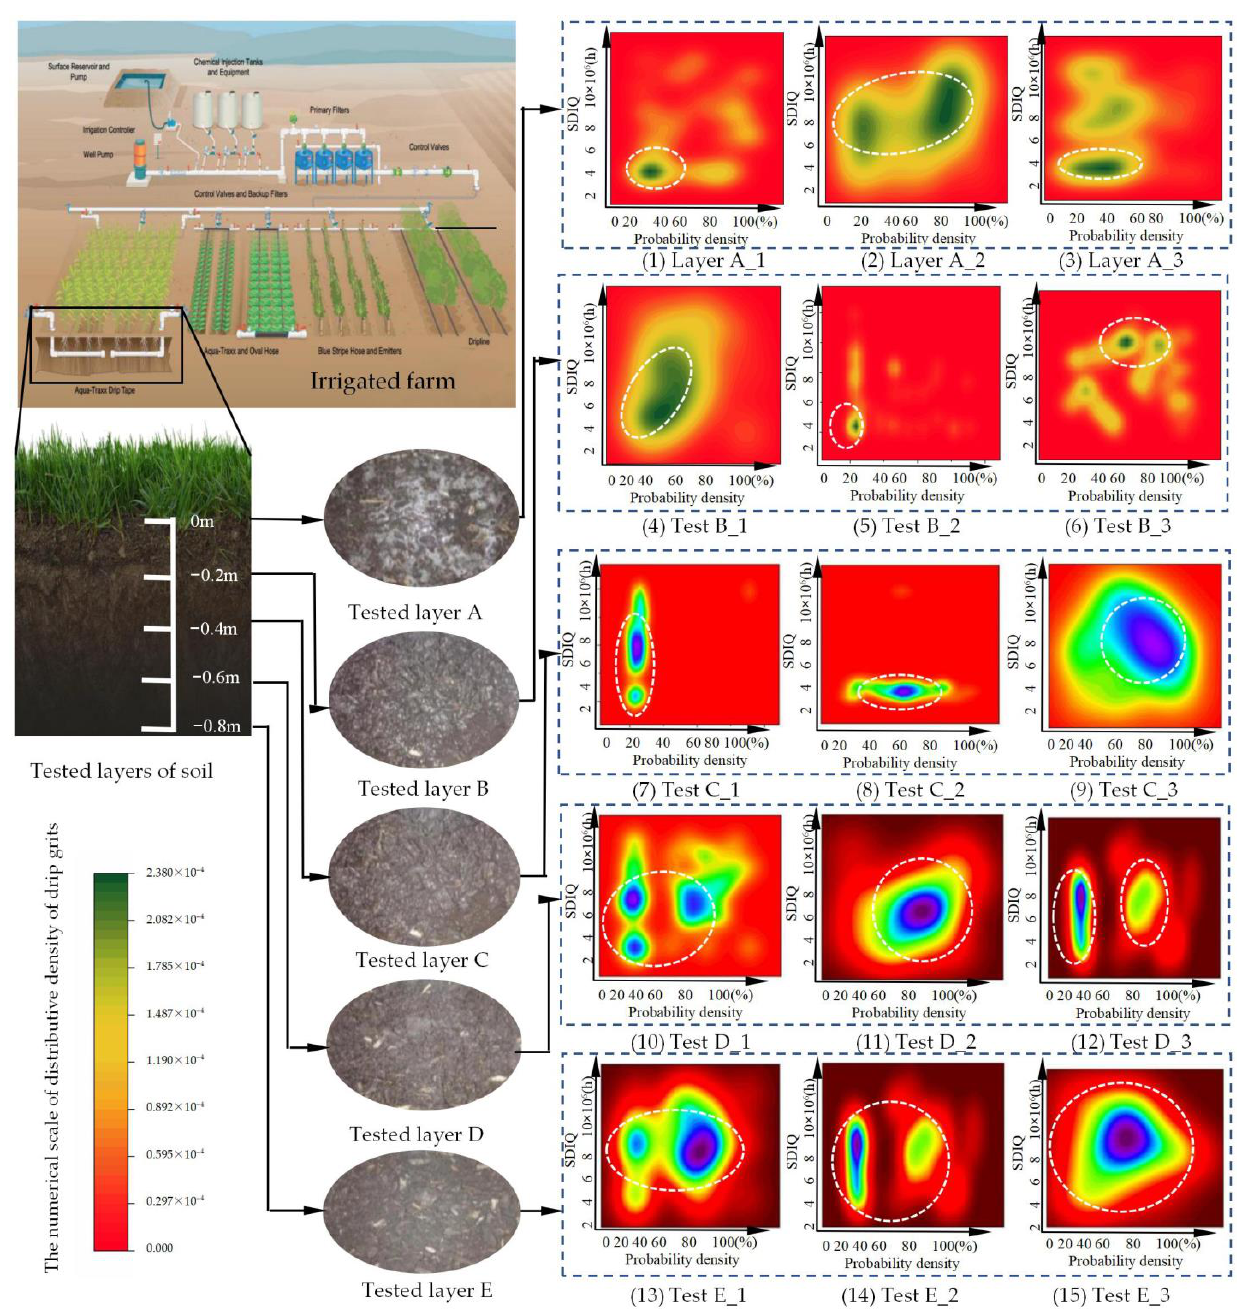
Figure 2. The kernel density figure describing the drip infiltration on the example soil surface. Here, the key distributive area with high SDIQ values is identified by white circles. the key distributive area with high SDIQ values is identified by white